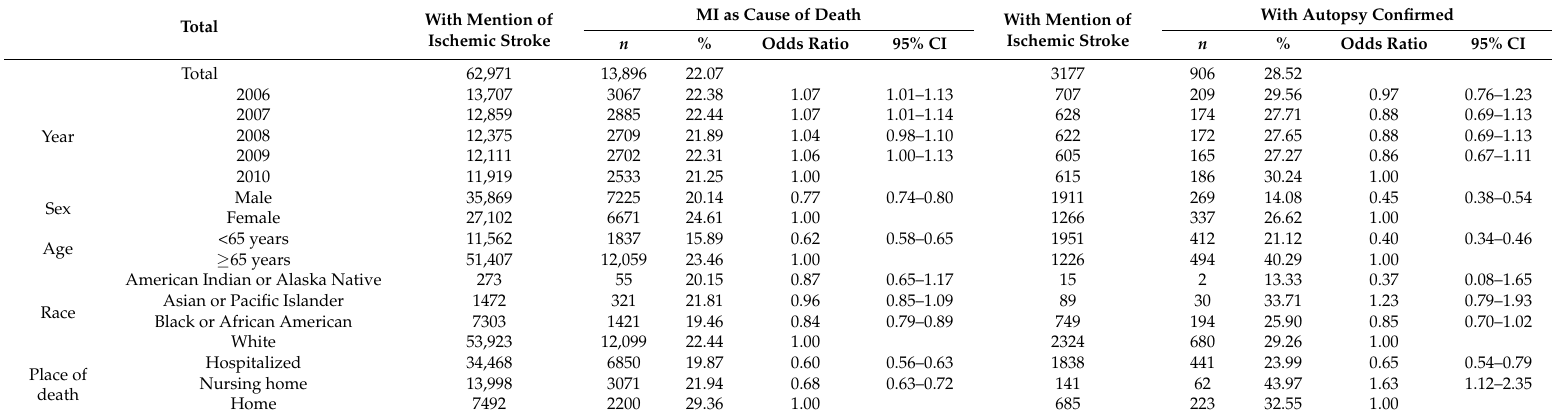
Table 2. The incidence and odds ratio of reporting myocardial infarction (MI) as a cause of death on death certificates with mention of ischemic